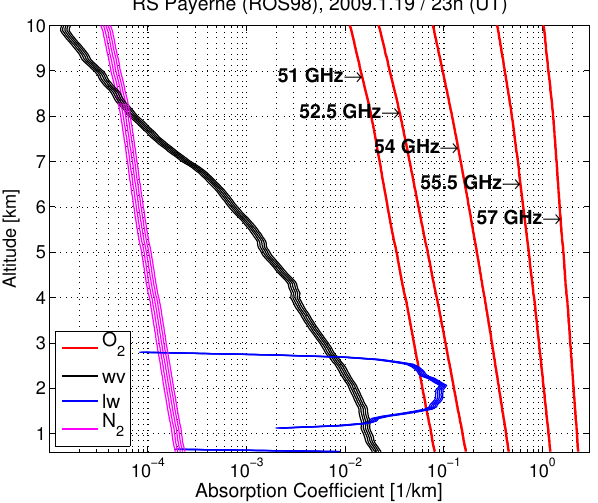
24 Fig. 5. Absorption Coefficient versus altitude for oxygen (O 2 ), wa- ter vapor (wv), liquid water (lw) and nitrogen (N 2 ) at 51, 52.5, 54, 55.5 and 57GHz calculated with radiosonde data from Payerne on 19 January 2009 (IWV=13.11mm, ILW=0.19mm). Calculations made with the Rosenkranz (1998)